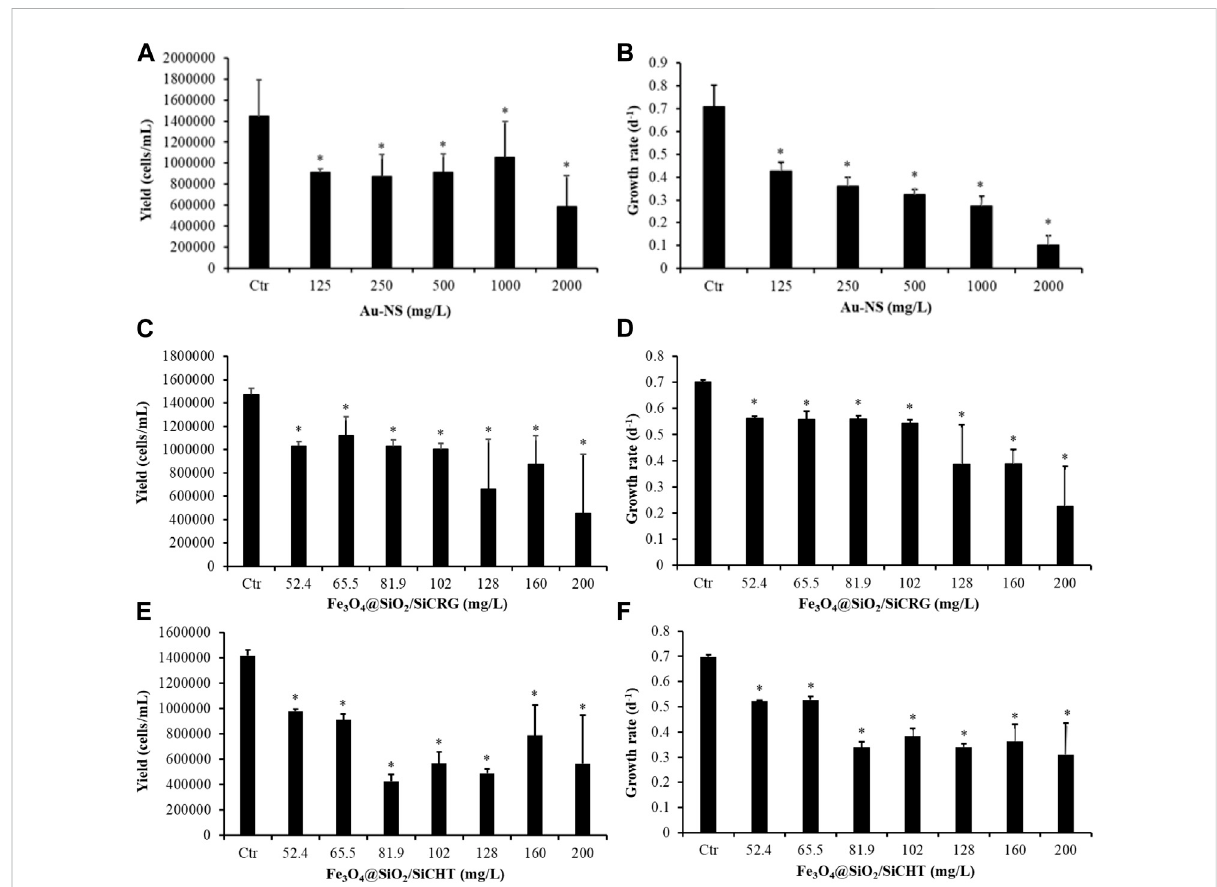
FIGURE 10 Average yield andgrowth rateof Raphidocelis subcapitata after beingexposed,for 72 h,to several concentrationsofgold nano-speres( (A) and (B) Au-NS) and of Fe 3 O 4 nanoparticles coated with κ -carrageenan hybrid siliceous shells ( (C) and (D) Fe 3 O 4 @SiO 2 /SiCRG) and Fe 3 O 4 nanoparticles coated with chitosan hybrid siliceous thin shells ( (E) and (F) Fe 3 O 4 @SiO 2 /SiCHT). * Indicates signi fi cant differences from the respective control ( p <